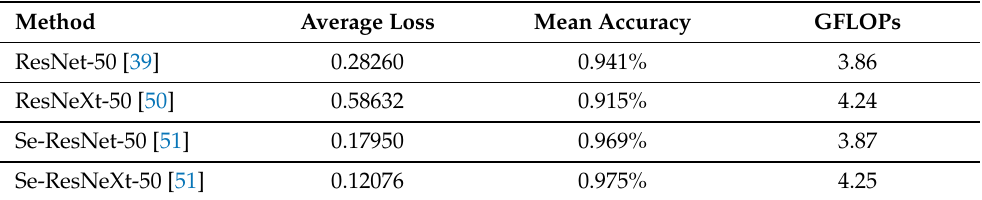
Table 8. Performance comparison of Cylinder bonding